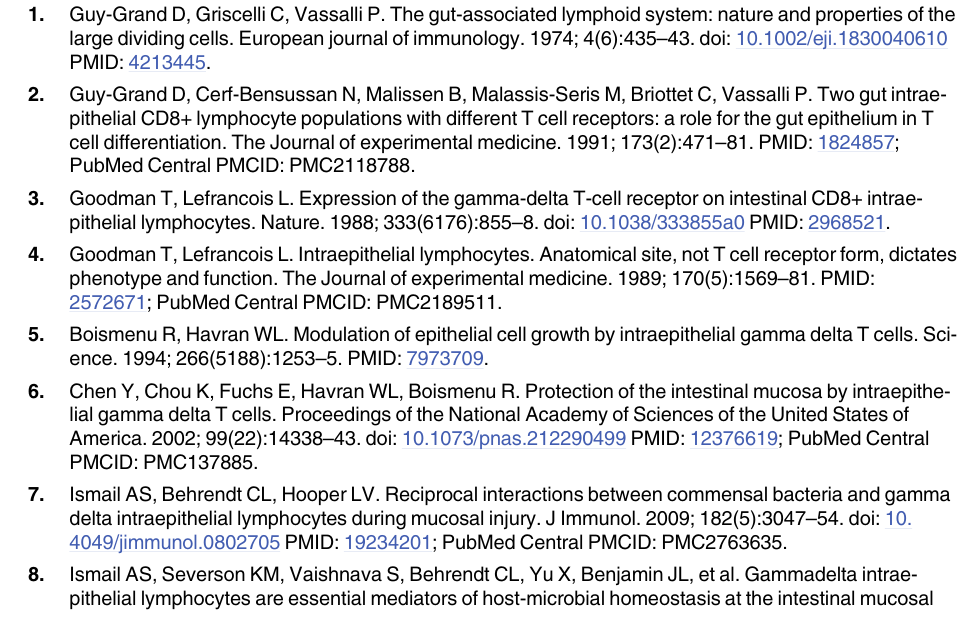
S3 Fig. Flow cytometric gating strategy for mature splenic lineages and B cell progenitors. (A) Splenocytes were gated as shown to identify B cells, T cells, monocytes, and granulocytes. (B) Bone marrow cells were stained for Hardy Fractions A-E as shown. (C) Strategy to identify mature B cell subsets in the spleen. S1 Table. Flow cytometric antibodies. Antibody specificities, clone numbers, fluorescent con- jugates, and vendors and sources are